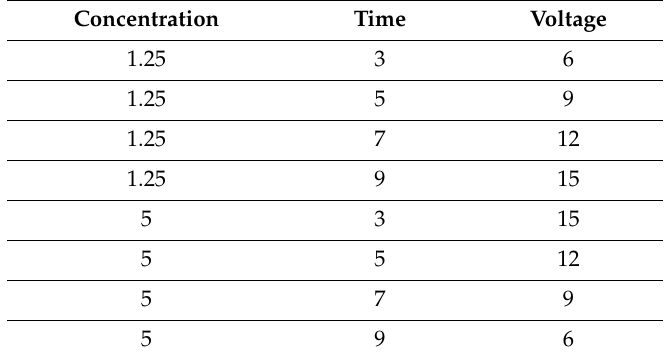
Table 2. Mixed design